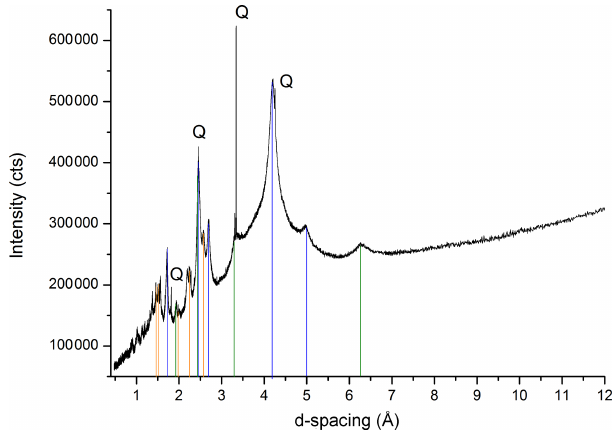
Figure 5. The X-ray diffraction pattern of minerals within OC parti- cles from mountain soil. Highly reactive Fe oxyhydroxides are iden- tified and denoted with lines of different colors: ferrihydrite (ICDD 01-073-8408, orange), goethite (ICDD 01-073-6522, blue), and lep- idocrocite (ICDD 00-044-1415, green). Q stands for Quartz (ICDD 00-033-1161). Details are included in Table S1.